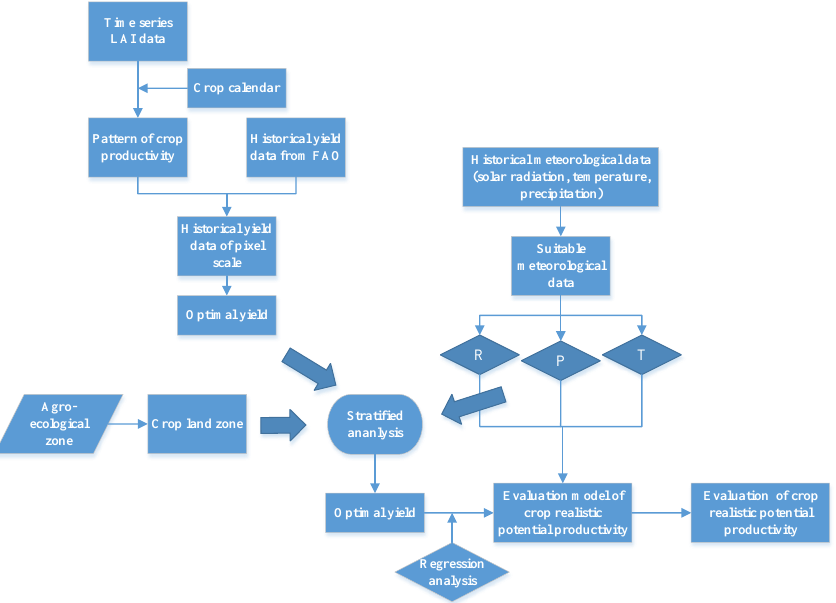
Figure 3. Schematic of the steps to evaluate crop realistic potential